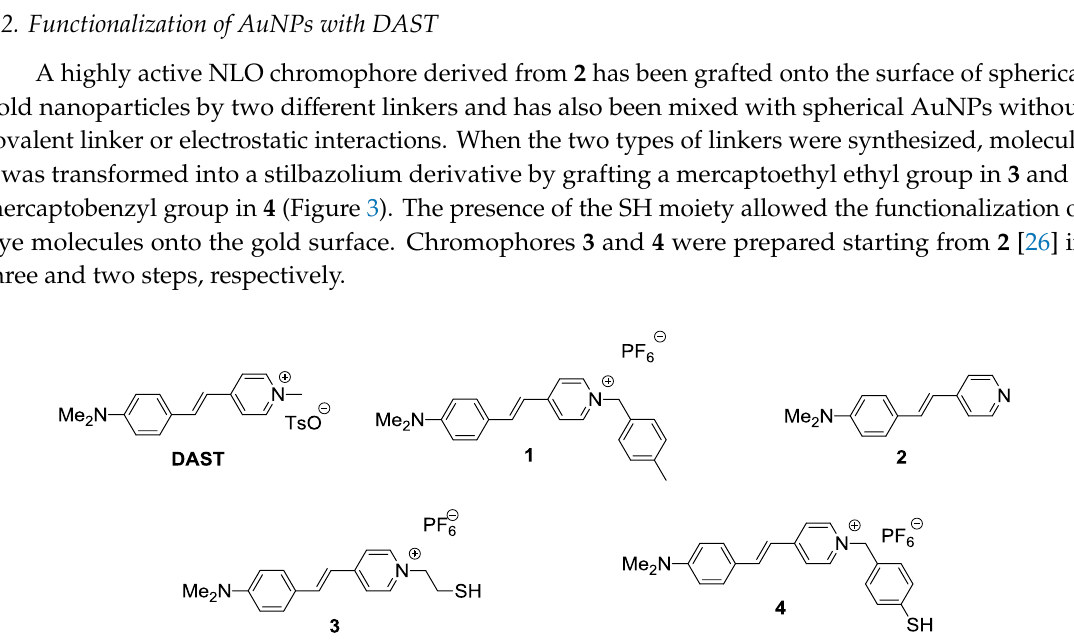
Figure 3. 4-dimethylamino- N -methyl-4-stilbazolium tosylate (DAST) derivatives with linkers.